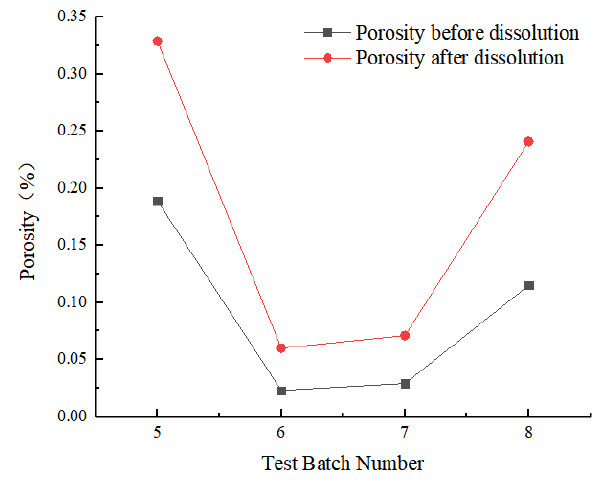
Figure 7. Porosity comparison before and after dissolution.